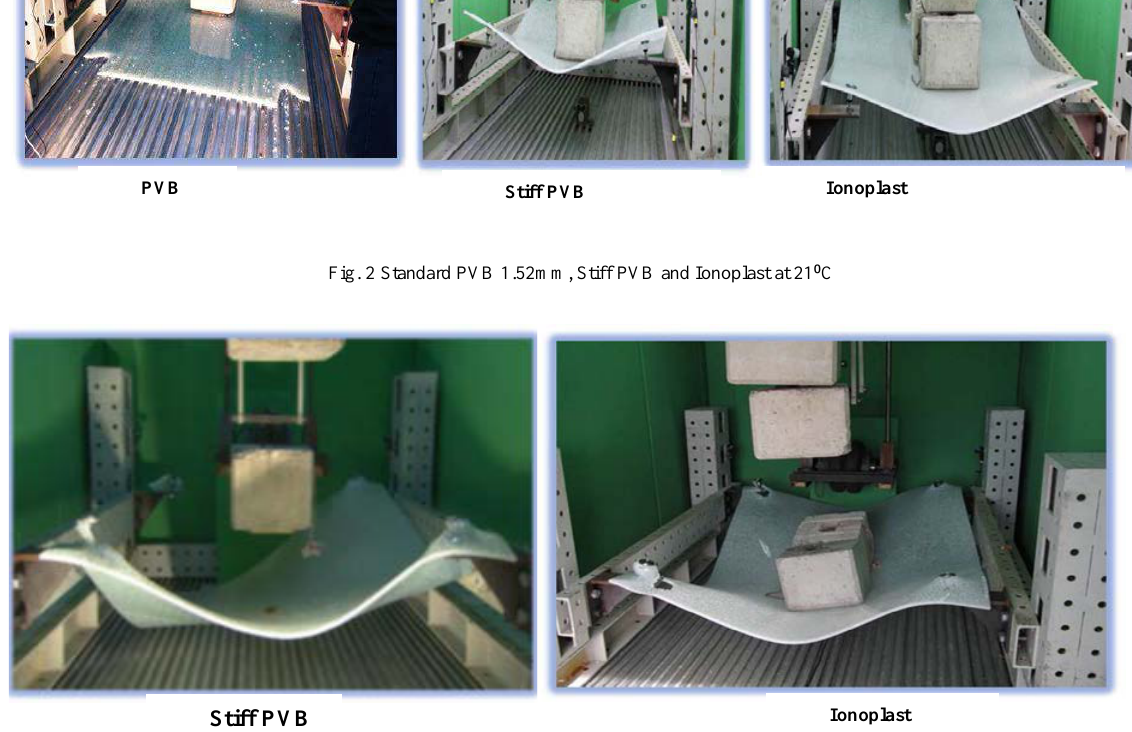
Fig. 3 Stiff PVB 1.52 mm and Ionoplast 0.89